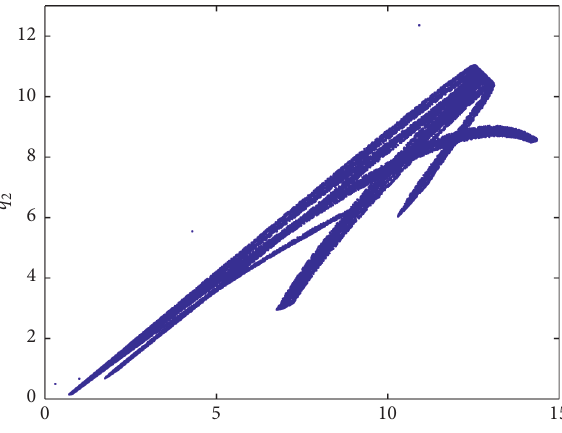
� 0 . 2 , c � 0 . 3, and β � 0 . 6. 1 2